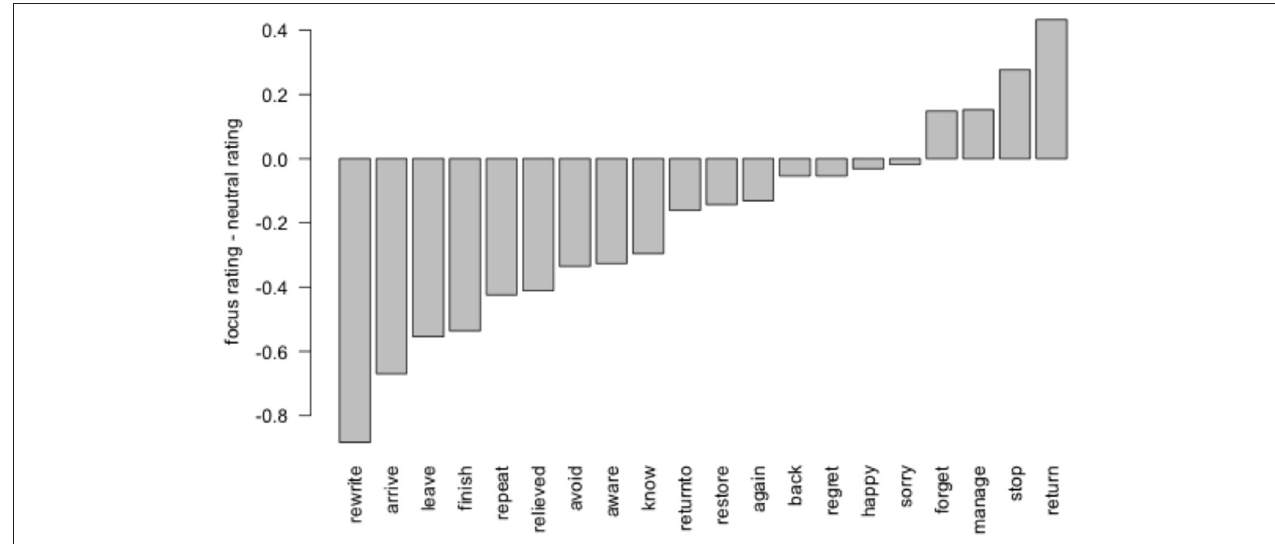
FIGURE 2 | Endorsement of the presupposed proposition in Experiment 2, by